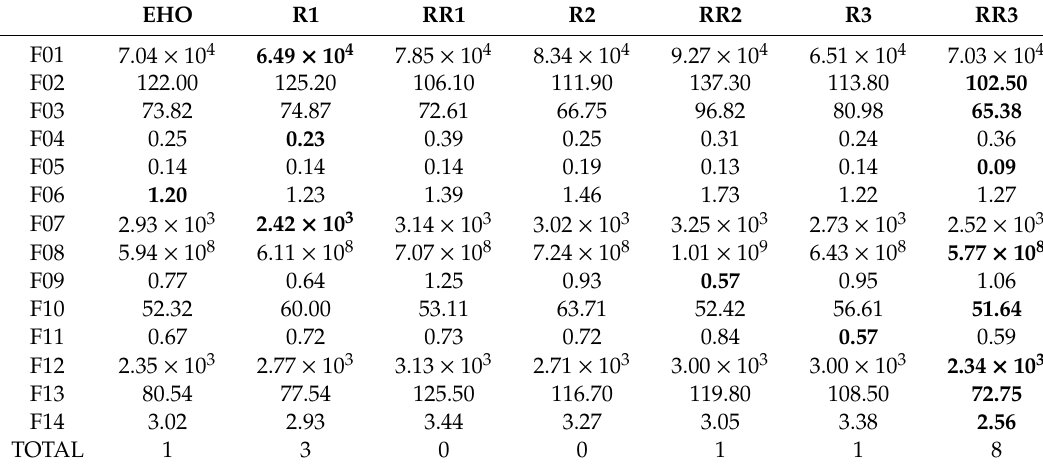
Table 17. Standard values obtained by EHO and six improved methods on fourteen CEC 2017 constrained optimization functions with D =